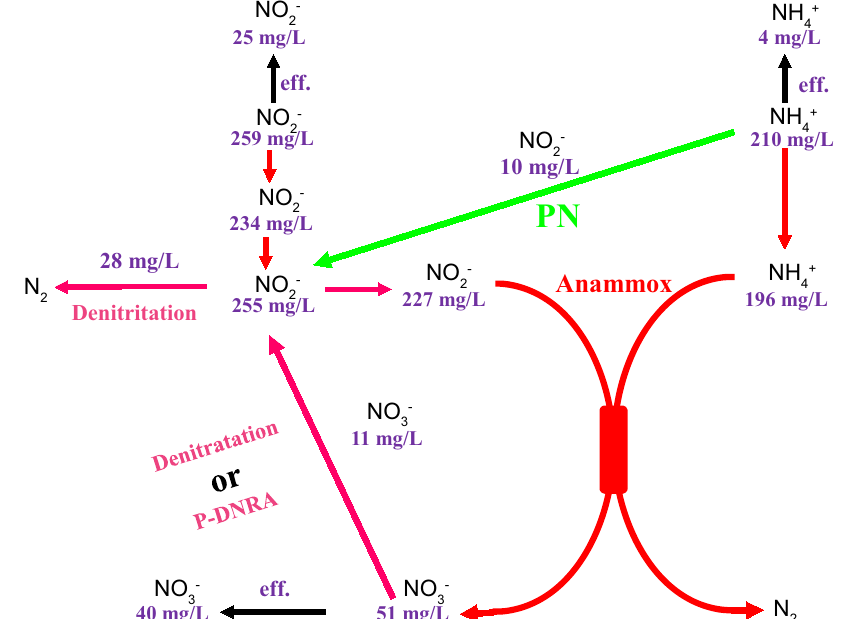
Fig. 3 Nitrogen mass balance of R4 on day 166. This mass balance is drawn on the base of anammox reaction stoichiometry. The black arrows showed the amount of nitrogen to ef fl uent, the red lines indicated anammox process, the green line indicated partial nitri fi cation process, and the pink arrows indicate partial denitri fi cation or partial-DNRA